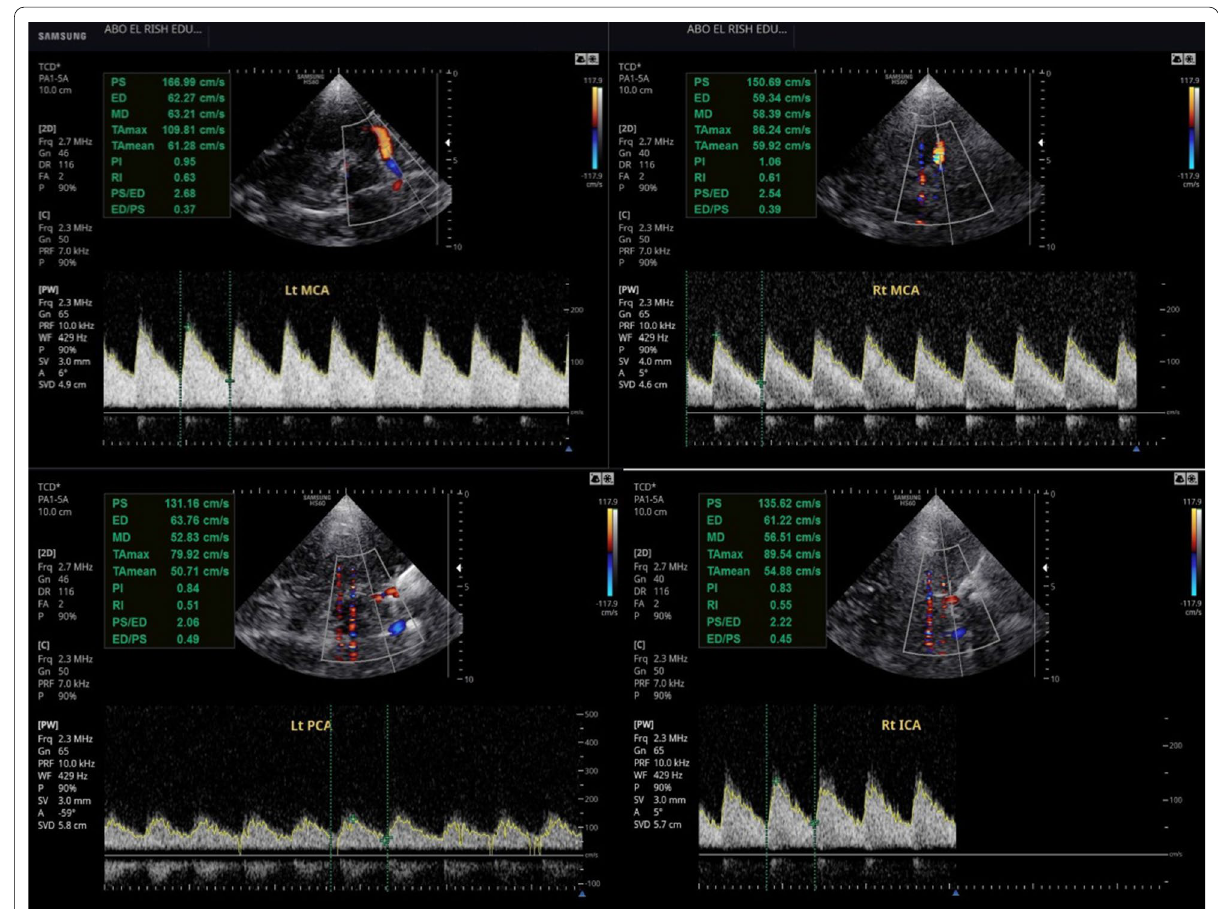
Fig. 2 4 years old male patient on regular blood transfusion, Transcranial Doppler measurements showing no risk of